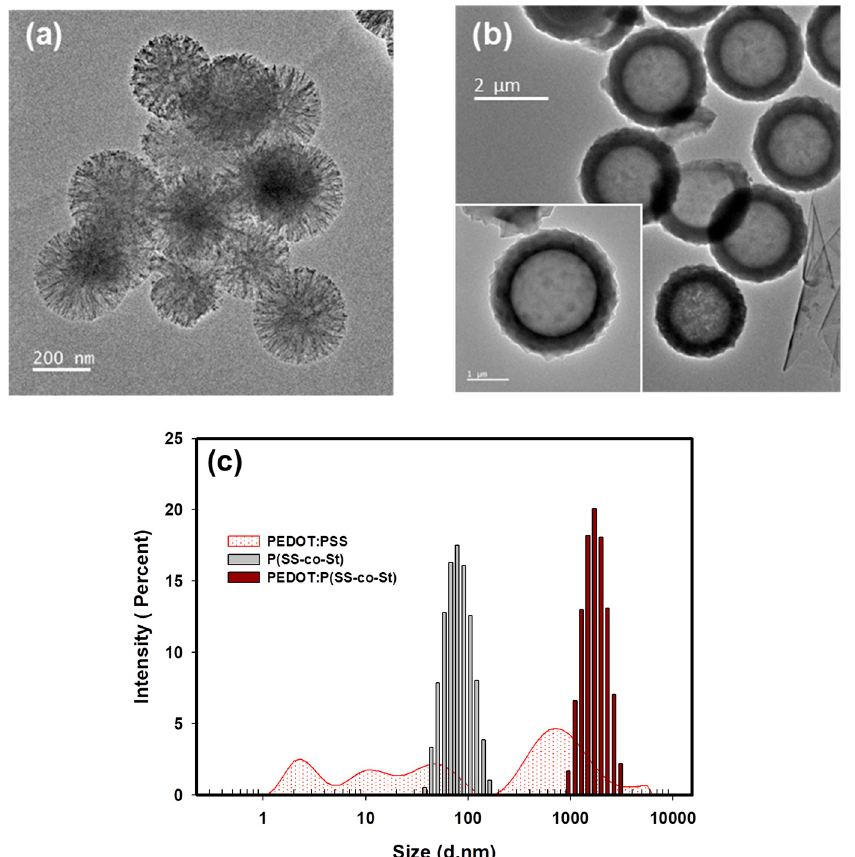
Figure 3. TEM images of ( a ) P(SS-co-St) and ( b ) PEDOT:P(SS-co-St); ( c ) DLS particle size distribution of PEDOT:PSS, P(SS-co-St), and PEDOT:P(SS-co-St).